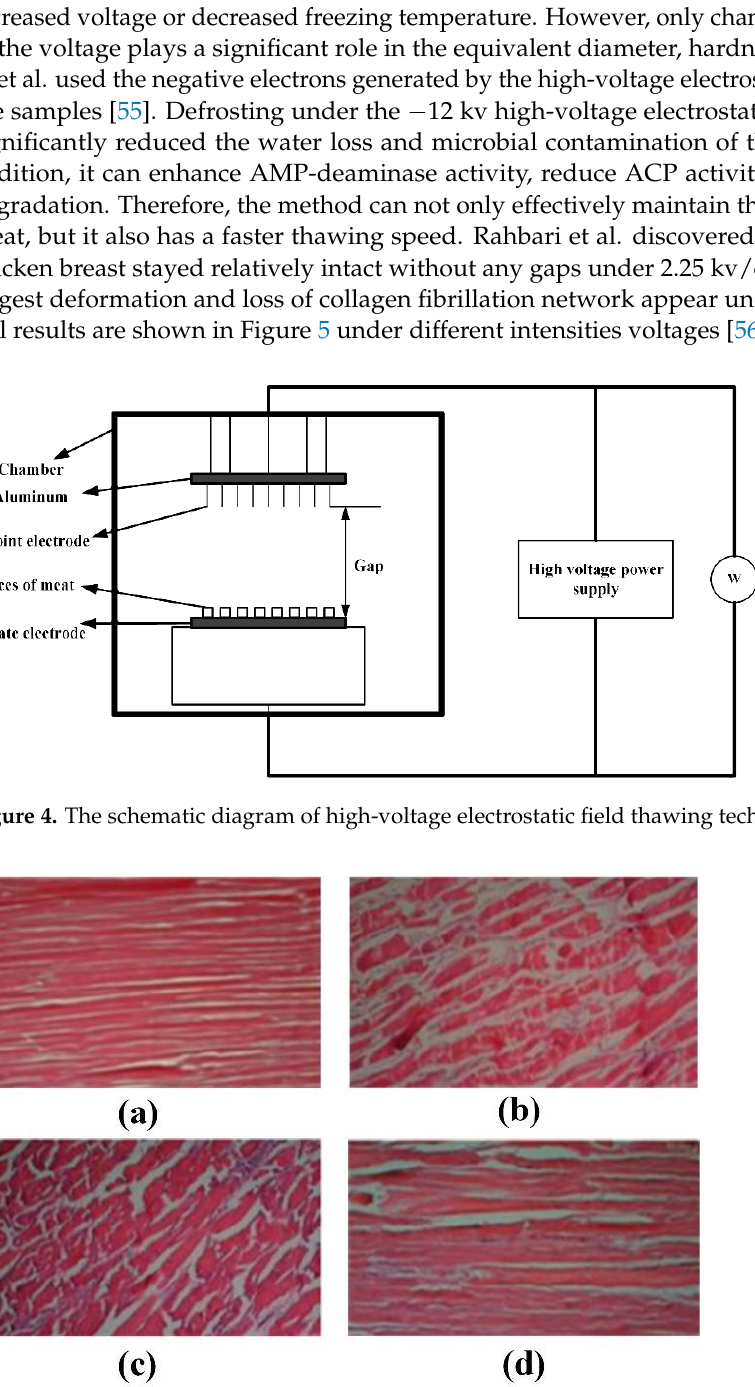
Figure 5. Sections of fresh chicken breast. ( a ) Thawed chicken breast by air method. ( b – d ) Thawed chicken breast by a high-voltage electrostatic field: ( b ) 1.5 kv/cm ( c ) 2.5 kv/cm ( d ) 3 kv/cm. Adapted with permission from ref. [56]. Copyright 2020 Wiley.